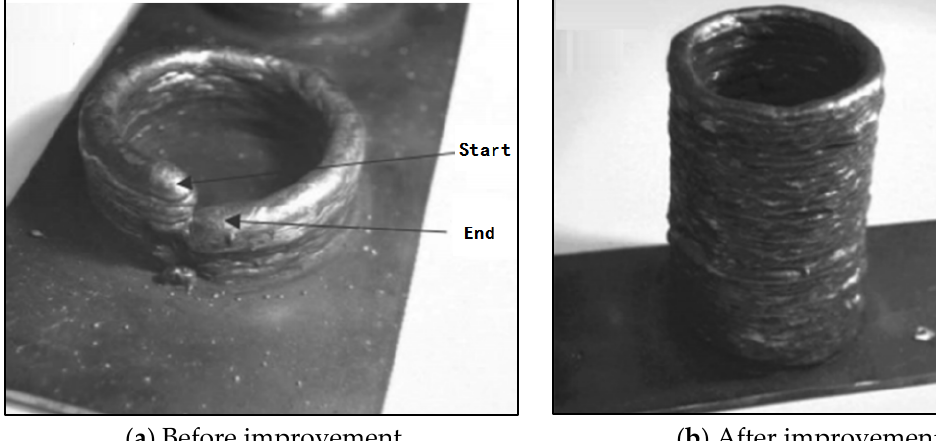
Figure 3. Tubular parts.